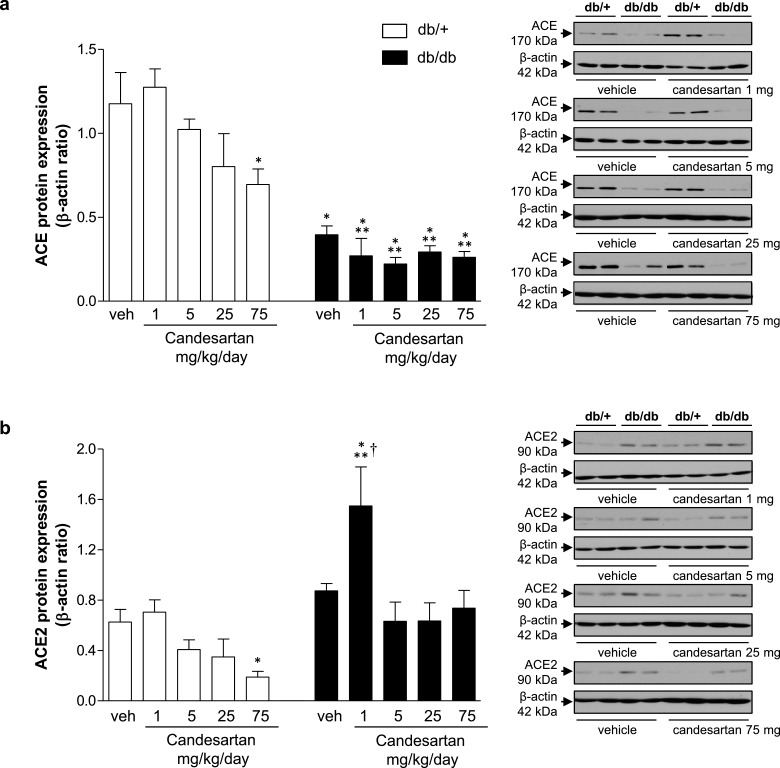
Intermediate dose of candesartan increases expression of ACE2 in kidney cortex from db/db miceProtein expression of ACE (a) and ACE2 (b) in kidney cortex from db/+ and db/db mice treated with vehicle or candesartan (1, 5, 25 or 75 mg/kg/d). Side panels, representative immunoblots of ACE, ACE 2 and β-actin. Results are presented as mean ± S.E.M. of 5–7 mice. *P<0.05 compared with vehicle-treated db/+; **P<0.05 db/db compared with db/+ of corresponding candesartan dose; †P<0.05 candesartan-treated db/db compared with vehicle-treated db/db.